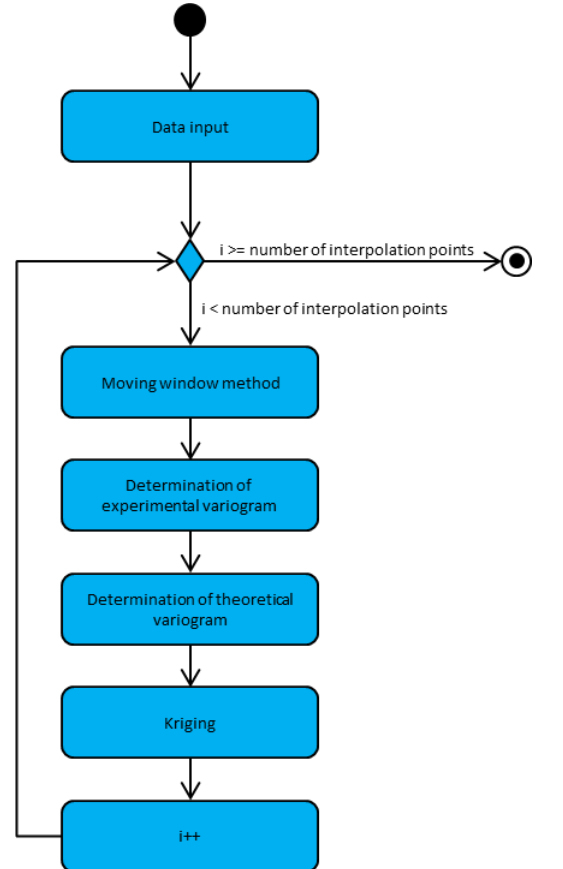
Figure 2. Design of information analysis